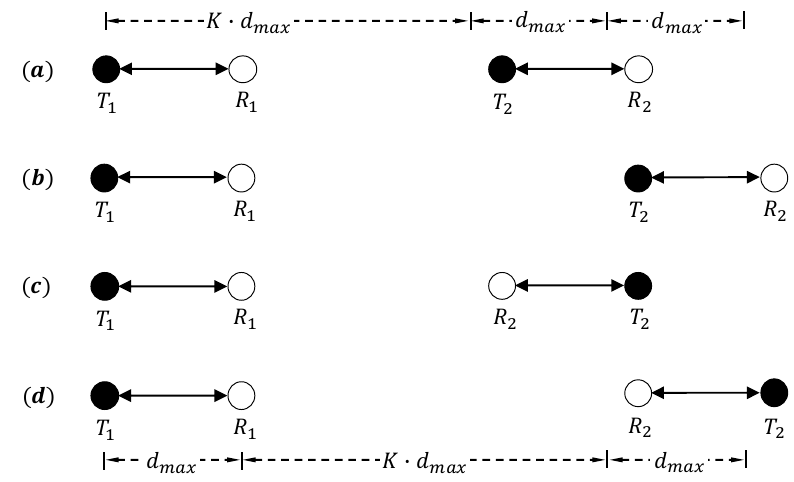
Figure 2. Diagram of interference from concurrent senders on the basis of coefficient K